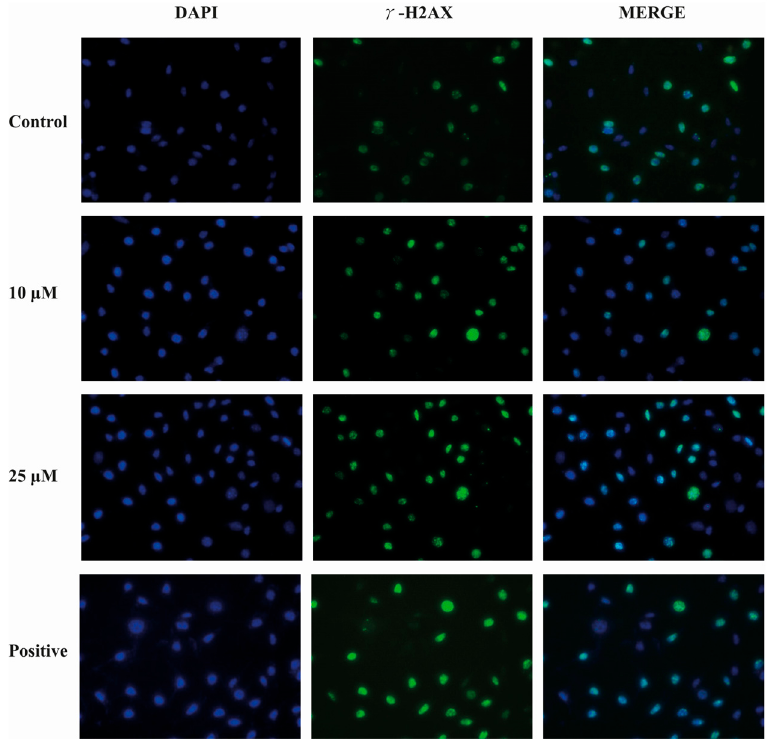
Figure 8. Representative images of DNA damage in HeLa cells. A 25 µM dose of compound E inhibited CAIX and apparently increased DNA damage marked with green γ -H2AX staining. Cell fragments were fixed and processed for γ -H2AX immunofluorescent staining (IFA). DAPI blue was used to detect